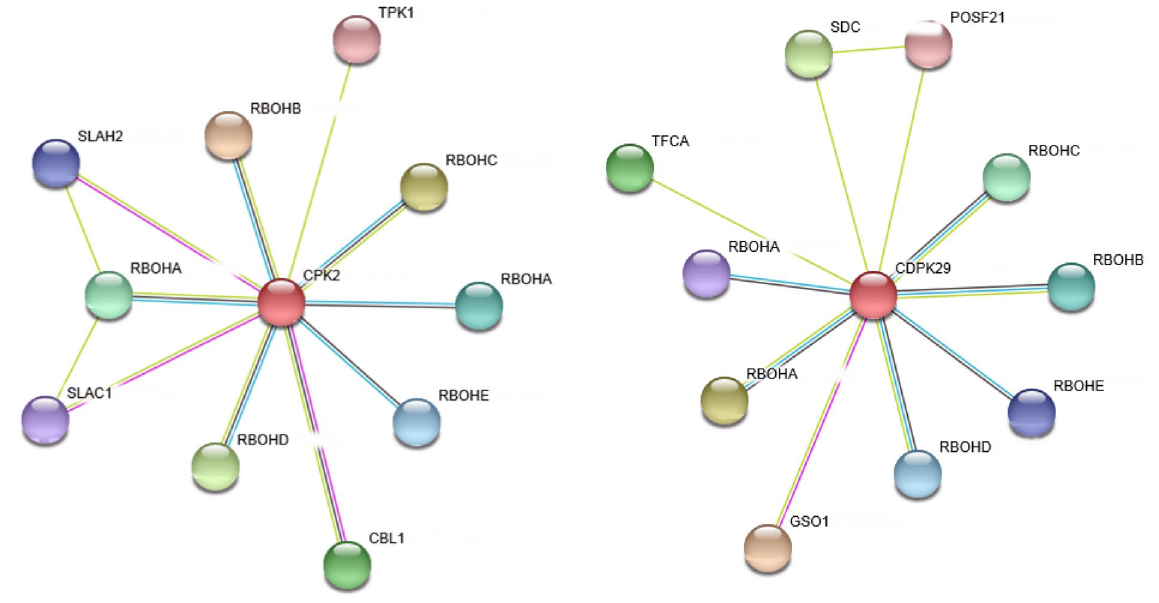
Figure 7. Interaction network analysis of Fa CDPK4 and Fa CDPK11 proteins identified in Fragaria x ananassa . The analysis was performed with the respective homologous in Fragaria x vesca (CPK2 for FaCDPK4 and CDPK29 for FaCDPK11 ). Line color indicates the type of interaction evidence: Black line indicates co-expression; Green line indicates textmining; Blue line indicates